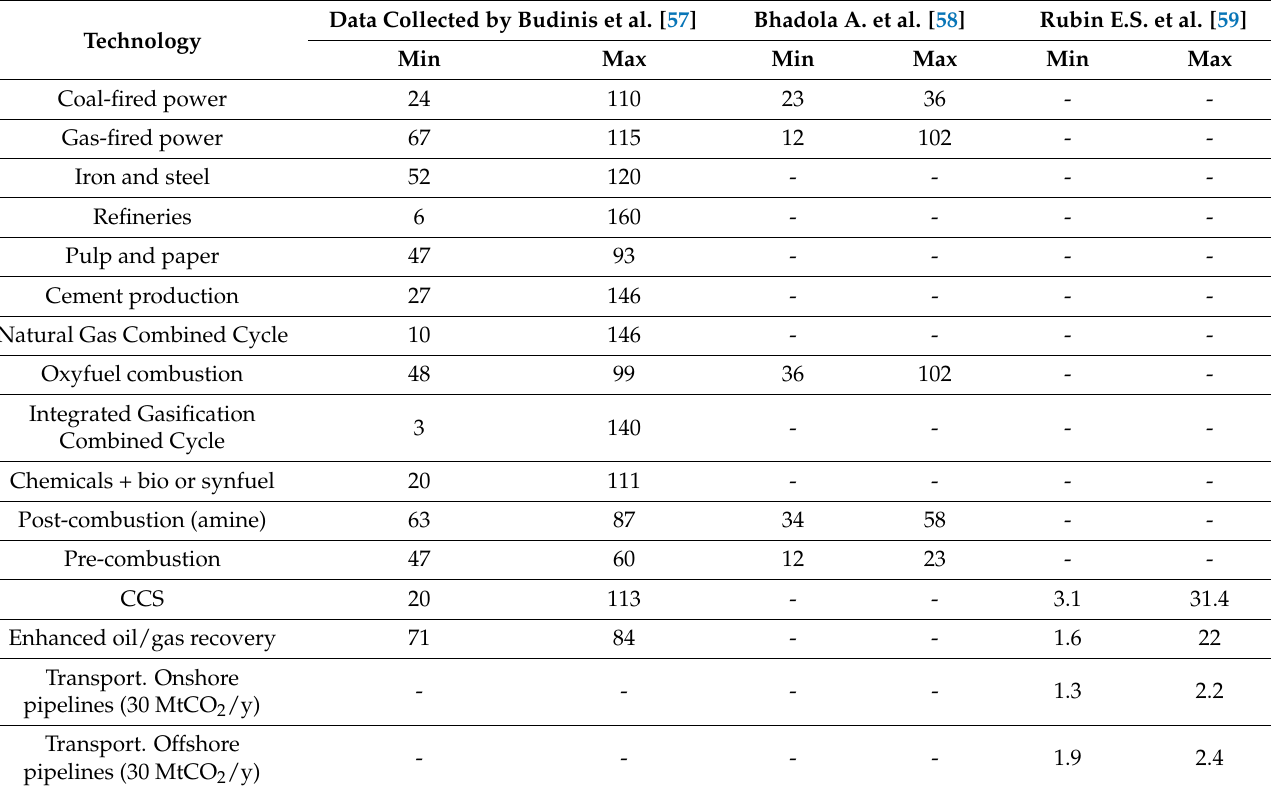
Table 1. Approximate cost of CCUS and CCS, USD/t CO